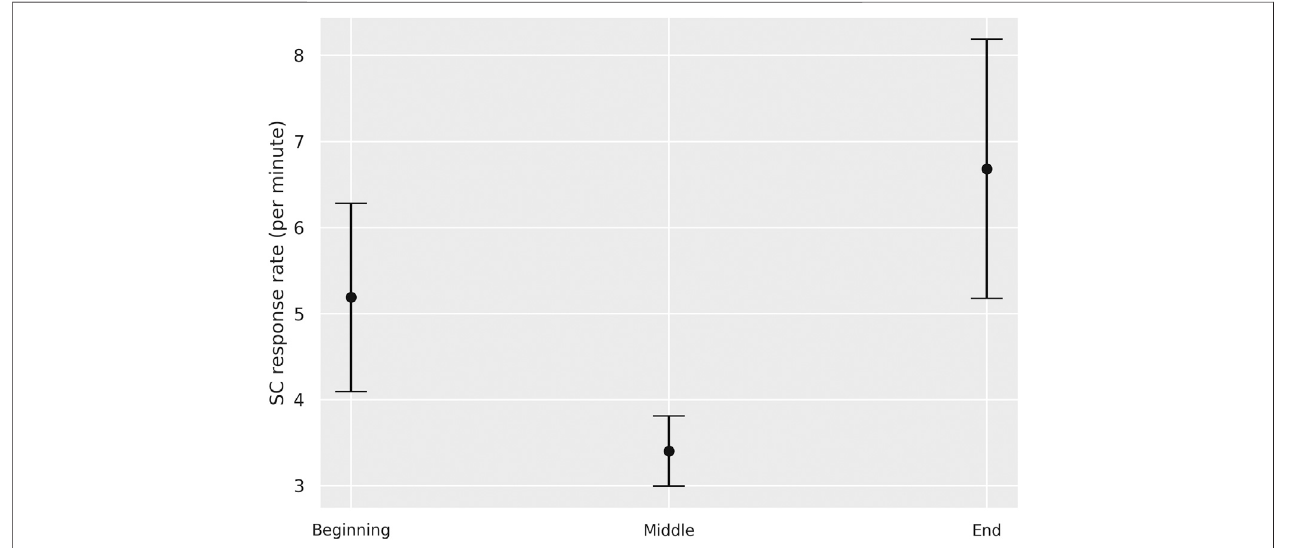
FIGURE2| MeanSCresponseratesand95%con fi denceintervalsinthebeginning,middleandendphase.Themiddlephasehadsigni fi cantlylowerSCresponse rates than the beginning and end phase.